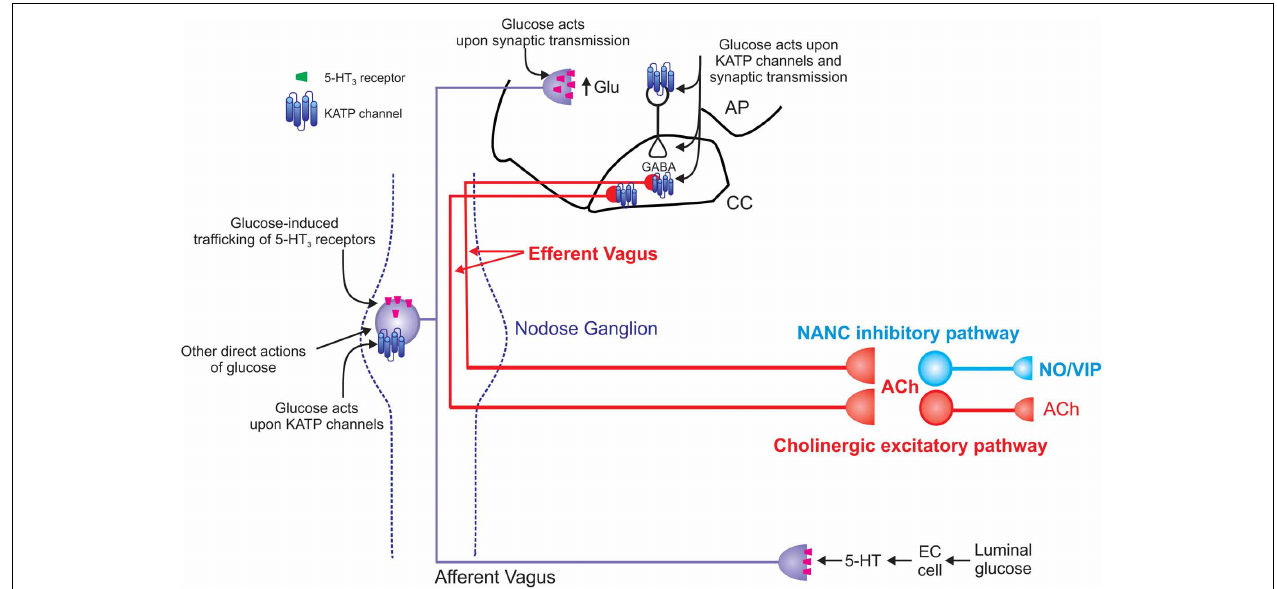
FIGURE 2 | Schematic representation of the effects of glucose on vago-vagal reflex control of the stomach. Glucose within the intestine induces the release of serotonin from enteroendocrine (EC) cells (Zhu et al., 2001; Freeman et al., 2006). The released 5-HT acts upon 5-HT3 receptors present on the peripheral terminals of vagal afferent neurons to cause their excitation (Hillsley et al., 1998; Raybould et al., 2003; Grundy, 2006); this peripheral signal is relayed centrally via the afferent vagus nerve. Once absorbed into the circulation, glucose is also able to act directly upon vagal afferent neurons within the nodose ganglion. Glucose induces neuronal excitation via actions upon ATP-sensitive potassium channels (KATP channels; Grabauskas et al., 2010) as well as causing neuronal inhibition via an as yet unidentified mechanism (Grabauskas et al., 2010). Glucose also rapidly and reversibly traffics 5-HT3 receptors to and from the membrane of gastrointestinal vagal afferent neurons (Babic et al., 2012). Since circulating platelet-free 5-HT levels increase following ingestion of a meal (Houghton et al., 2003), this provides a means by which glucose is able to modulate its own “perception” and amplify or prolong vagal afferent signaling. The central terminals of vagal